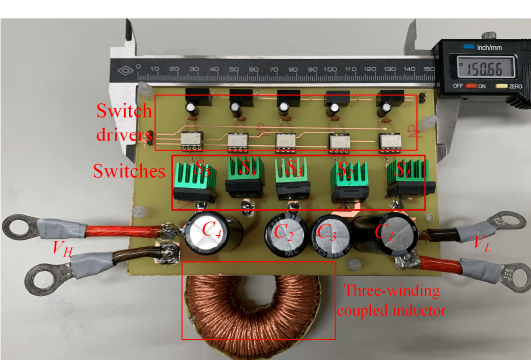
Figure 11. Photograph of the proposed converter.